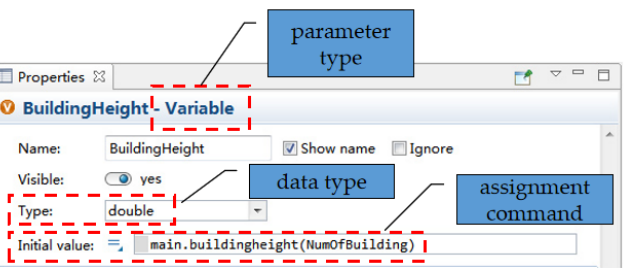
Figure 5. Example command for assignment of building height variable.